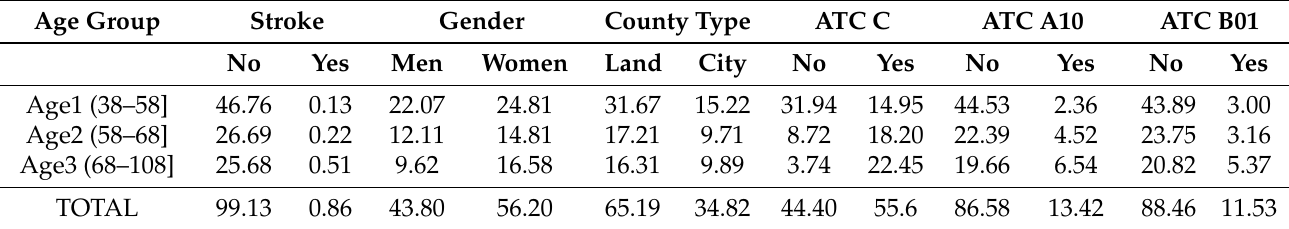
Table 1. Summary statistics of the dataset